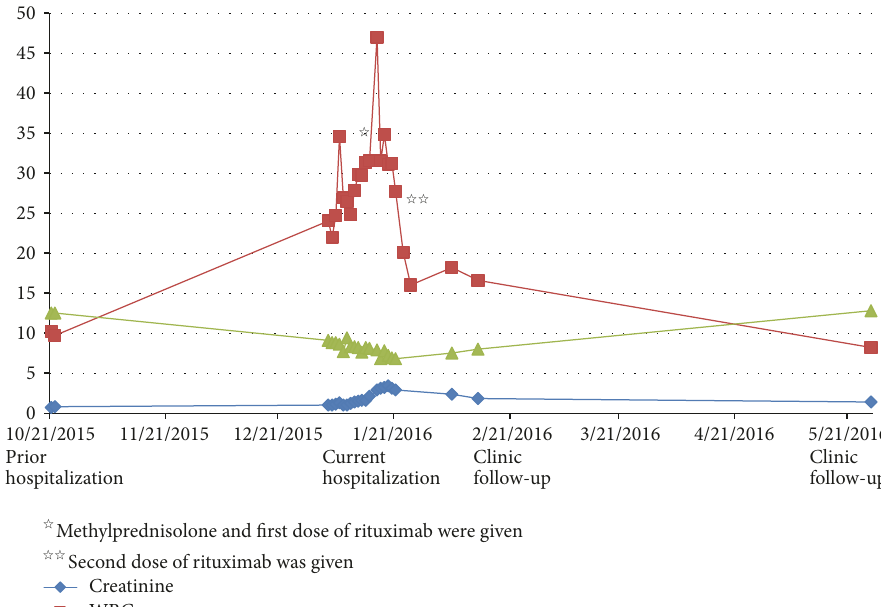
Figure 1: Relationship between serum creatinine, WBC, and haemoglobin . Upon initial presentation to our hospital several months earlier, patient had normal laboratory values. At this admission the patient had leukocytosis, anemia, and rising creatinine values. Administration of methylprednisolone and rituximab (star) was associated with an initial rise in WBC count. Within several days leukocyte counts began to decline, most notably after the second rituximab infusion (two stars). Haemoglobin and creatinine levels also responded appropriately. At the outpatient clinic follow-up the patient received another two doses of rituximab. Laboratory testing continued to show improved WBC count, haemoglobin, and creatinine levels.